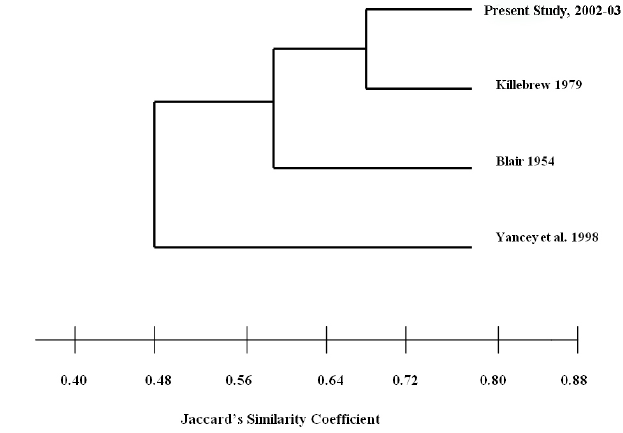
Figure 6. Jaccard similarity coefficient for the three mammal inventories of LMNRA, as well as Blair’s (1954)